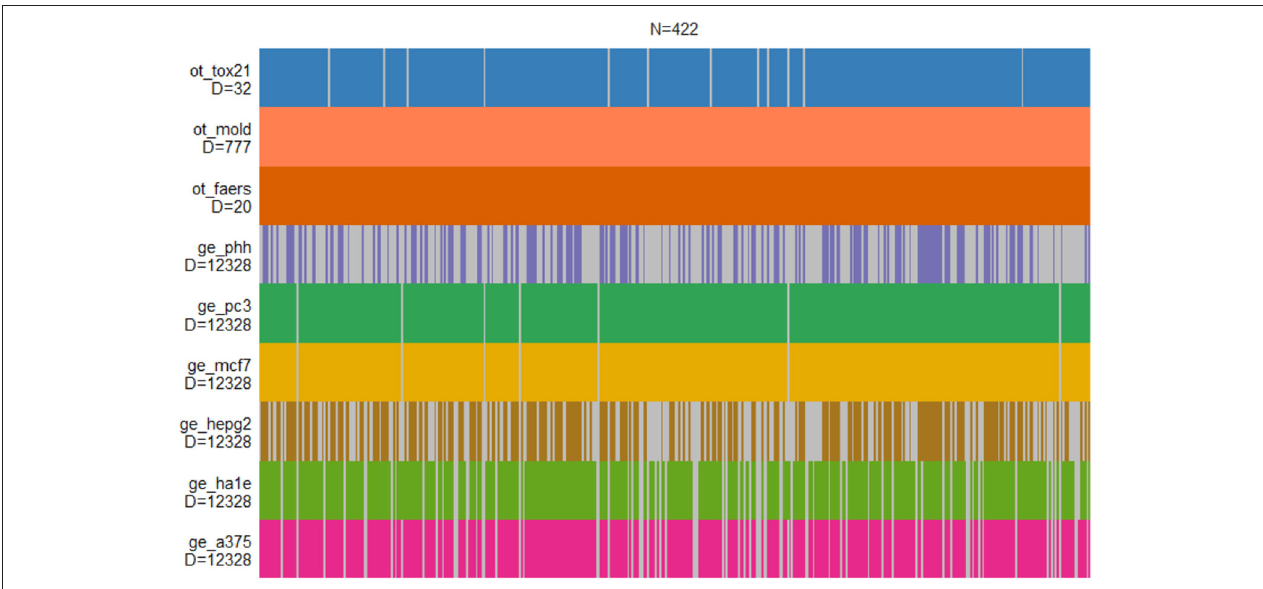
FIGURE 1 | Structure of drug-induced liver injury (DILI) data sets. Each vertical bar corresponds to the compound that is present in a given set. Only MOLD and FAERS data sets contain information on all